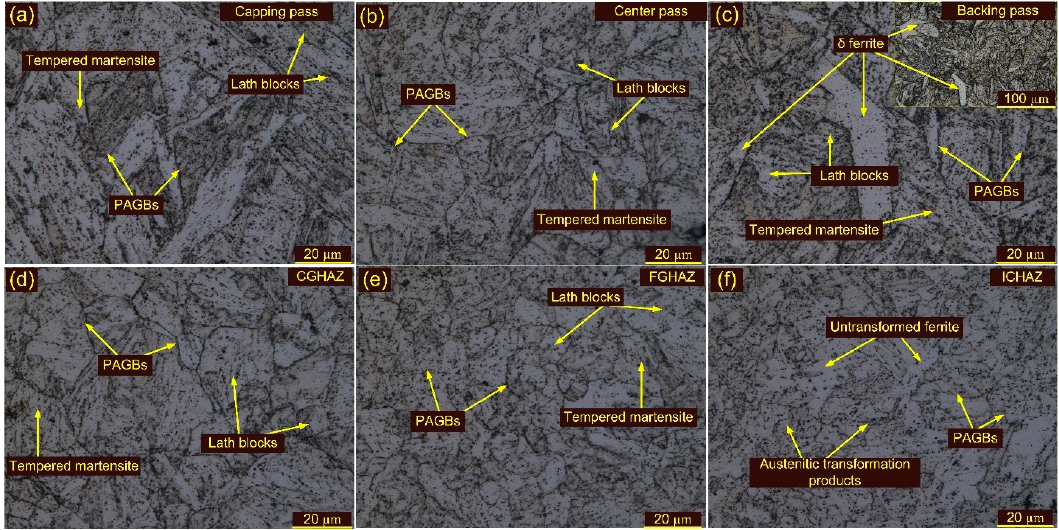
Figure 13. Weldments after HT1 treatment: WFZ ( a ) capping pass, ( b ) center pass, ( c ) backing pass; ( d ) CGHAZ, ( e ) FGHAZ, ( f ) ICHAZ.